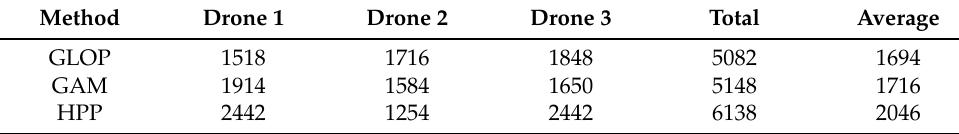
Table 9. Battery Drain (mAh).